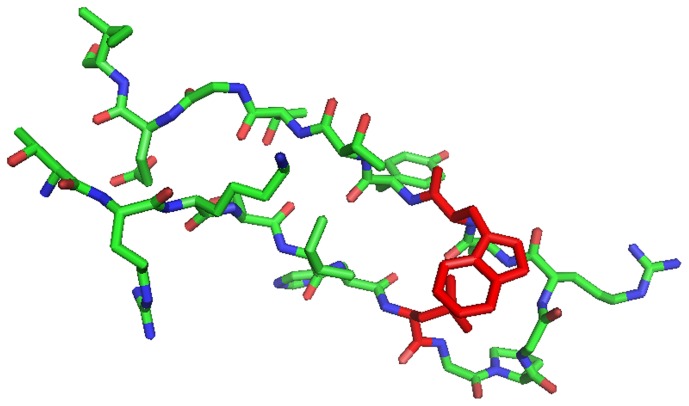
Structure of the V3 loop around pattern 1.In the NMR structure of the V3 loop by Rosen et al. [17] (PDB entry 2esx) the residues at HXB2 positions 14 and 22 have been mutated with pymol (DeLano Scientific LLC, San Francisco, CA, USA) into L and W, respectively (red), leaving the rest of the loop unchanged. The two modeled side chains are touching each other.